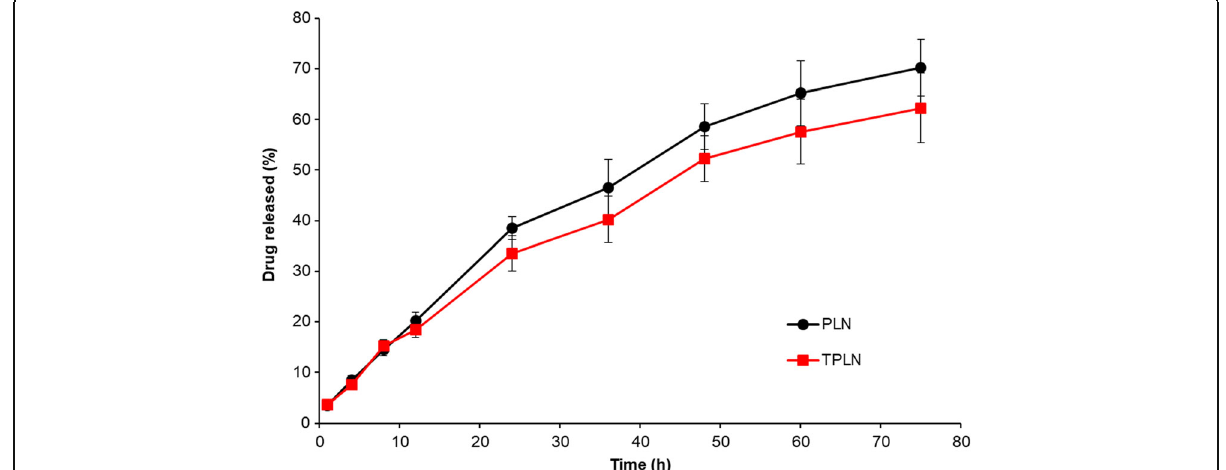
Fig. 3 In vitro drug release characteristics of PTX from PLN and TPLN from phosphate buffered saline (pH 7.4). The drug release was studied by dialysis method and the drug is quantified by HPLC method. The measurement was performed n = 3